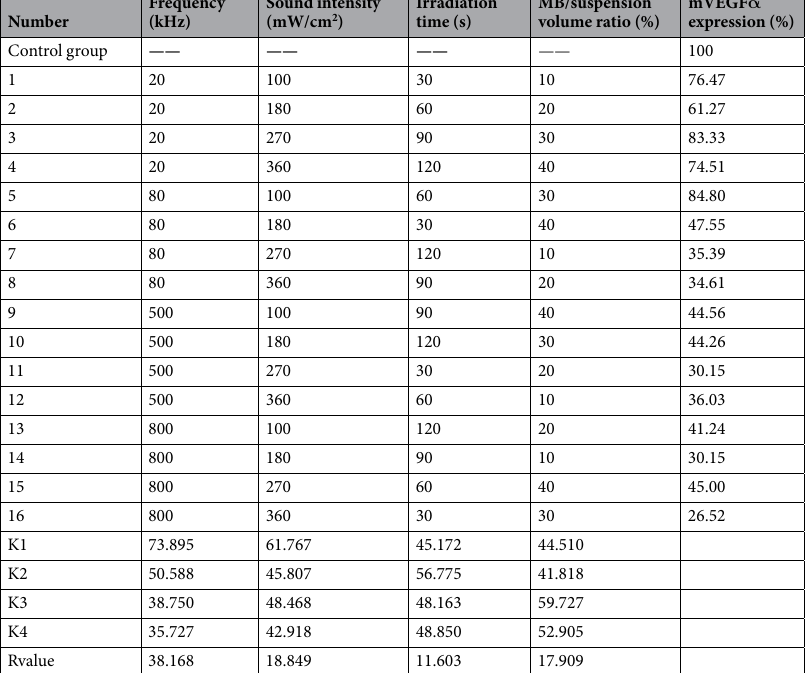
Table 1. The experimental design based on L 16 (4 4 ) orthogonal array and experimental results. K, Sum of mVEGF α for the factors at each level; k, The mean values for the factors at each level; R,